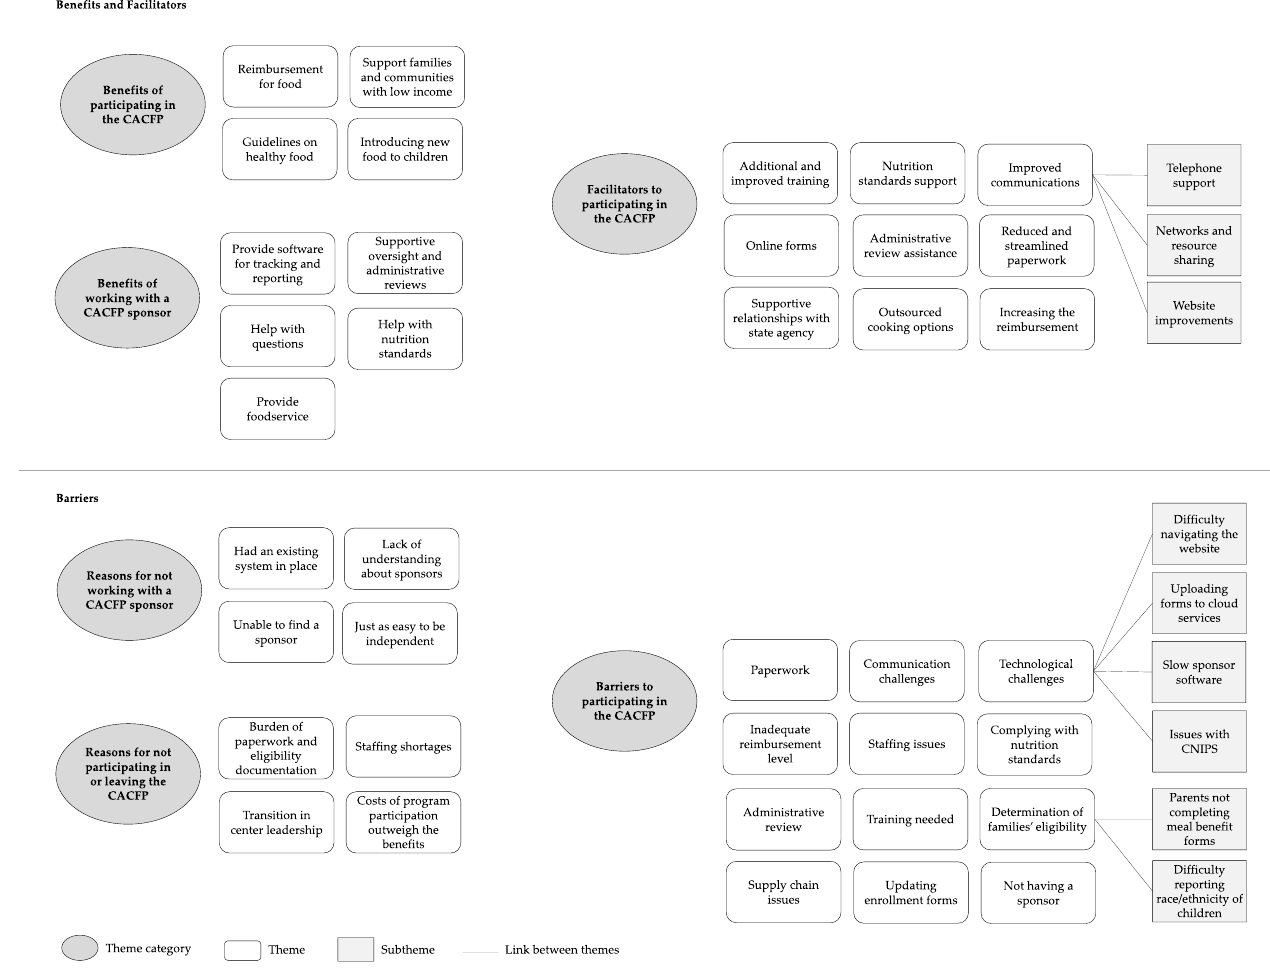
Figure 1. Emergent themes of benefits, barriers, and facilitators to participating in the Child and Adult Care Food Program (CACFP) and working with CACFP sponsors, as identified by independent child care centers and their sponsors located in California, United States.